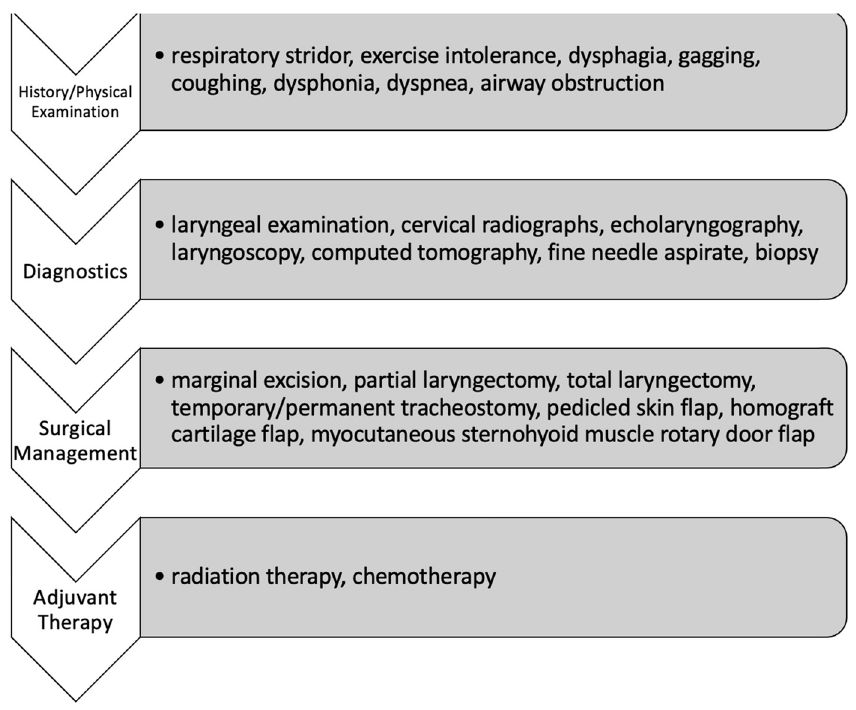
Figure 3: Typical history and physical examination fi ndings, diagnostics, surgical management, and follow - up chemoradiotherapy for canine patients with tumors of the